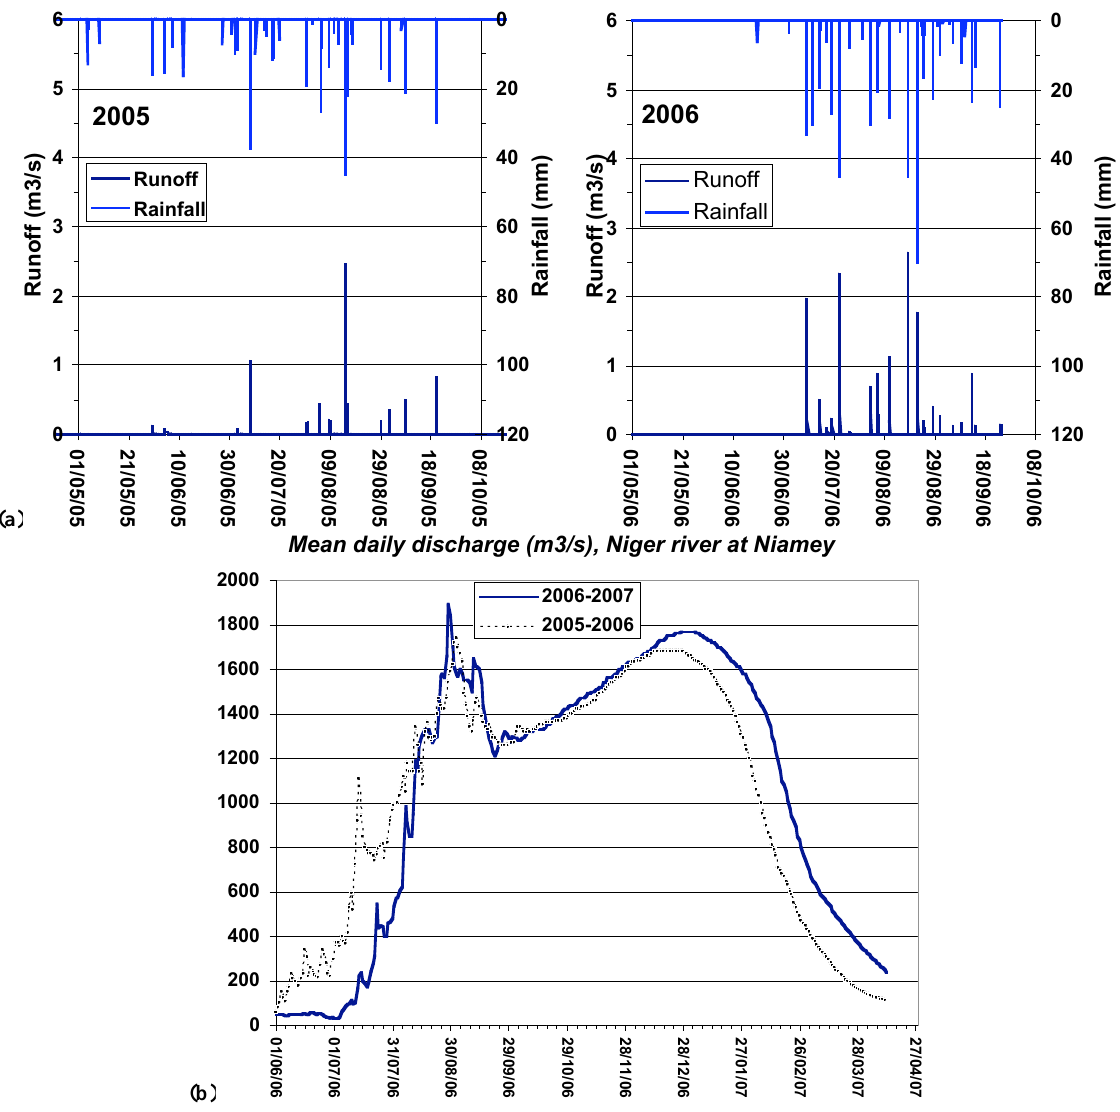
Fig. 23. Surface hydrology of the Sahel in 2006, compared to that of 2005. (a) Local scale (Wankama catchment, 2km 2 , on the Niamey Figure 23. Surface hydrology of the Sahel in 2006, compared to that of 2005. a. Local scale Meso-site): with a similar total rainfall of around 500mm for the 2 years (top-down bars), rain events of higher intensity were recorded in 2006, resulting in higher runoff (bottom-up bars). (b) Regional scale (Niger River at Niamey, 860000km 2 ) : the 2006 flood started unusually (Wankama catchment, 2 km 2 , on the Niamey Meso-site): with a similar total rainfall of late but the two flood peaks of August and December were larger in 2006 than in around 500 mm for the 2 years (top-down bars), rain events of higher intensity were recorded in 2006, resulting in higher runoff (bottom-up bars). b. Regional scale (Niger River at Figure 23. Surface hydrology of the Sahel in 2006, compared to that of 2005. a. Local scale Figure 23. Surface hydrology of the Sahel in 2006, compared to that of 2005. a. Local scale Niamey, 860,000 km 2 ): the 2006 flood started unusually late but the two flood peaks of (Wankama catchment, 2 km 2 , on the Niamey Meso-site): with a similar total rainfall of (Wankama catchment, 2 km 2 , on the Niamey Meso-site): with a similar total rainfall of August and December were larger in 2006 than in 2005. around 500 mm for the 2 years (top-down bars), rain events of higher intensity were recorded around 500 mm for the 2 years (top-down bars), rain events of higher intensity were recorded in 2006, resulting in higher runoff (bottom-up bars). b. Regional scale (Niger River at in 2006, resulting in higher runoff (bottom-up bars). b. Regional scale (Niger River at Niamey, 860,000 km 2 ): the 2006 flood started unusually late but the two flood peaks of Niamey, 860,000 km 2 ): the 2006 flood started unusually late but the two flood peaks of August and December were larger in 2006 than in 2005. August and December were larger in 2006 than in 2005.